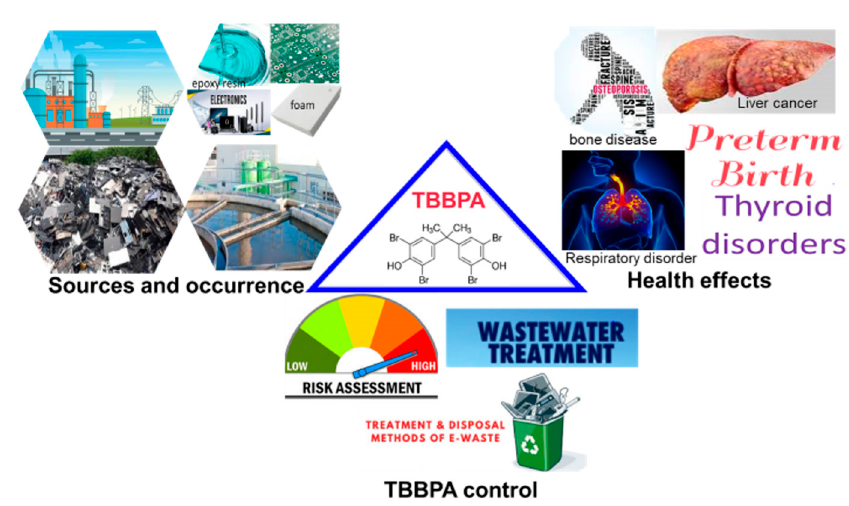
Figure 3. Schematic illustration of the sources and occurrence of TBBPA in the environment, health effects and control.